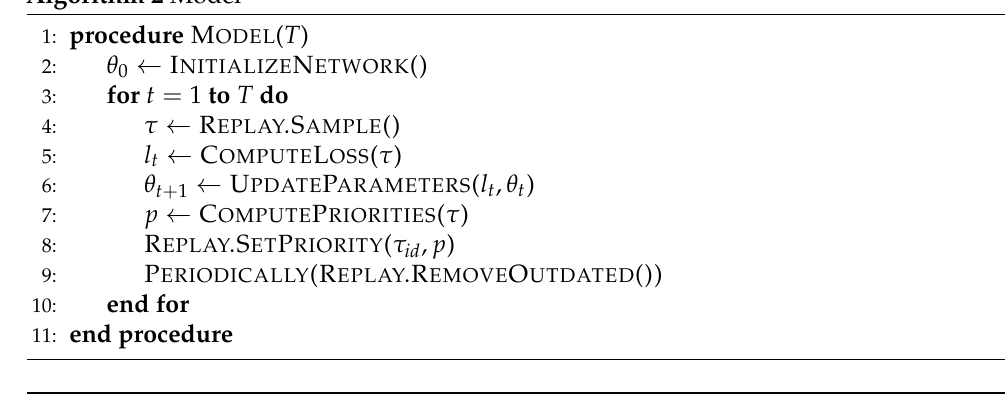
Algorithm 3 Model Replay